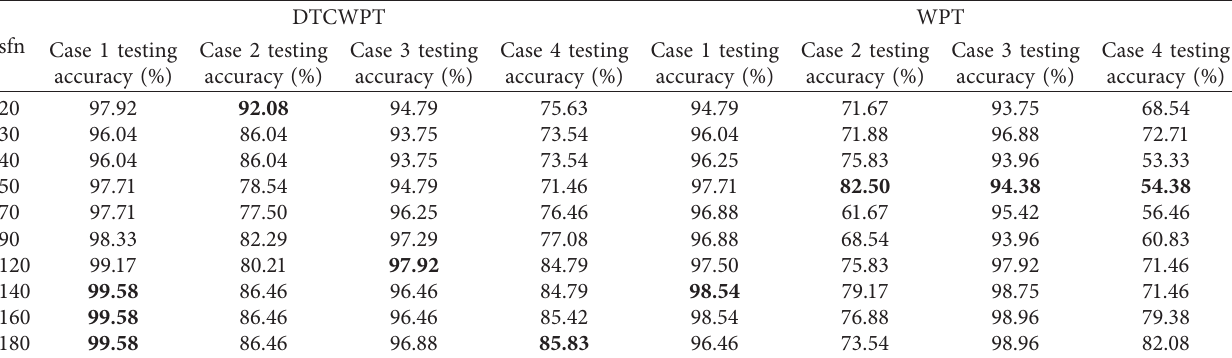
Dimension size is 11. Table 15: Testing accuracies obtained by OFS-TSFRS-MMC-SVM. DTCWPT sfn